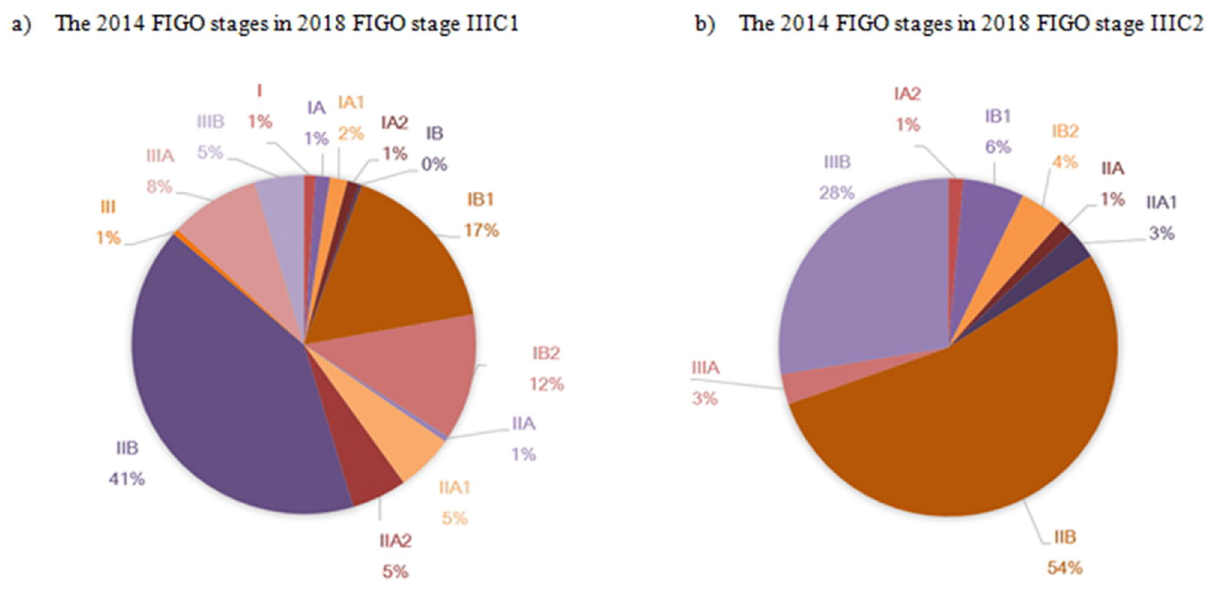
Figure 3. Distribution of 2014 FIGO stages in the 2018 FIGO stages IIIC1 ( a ) and IIIC2 ( b